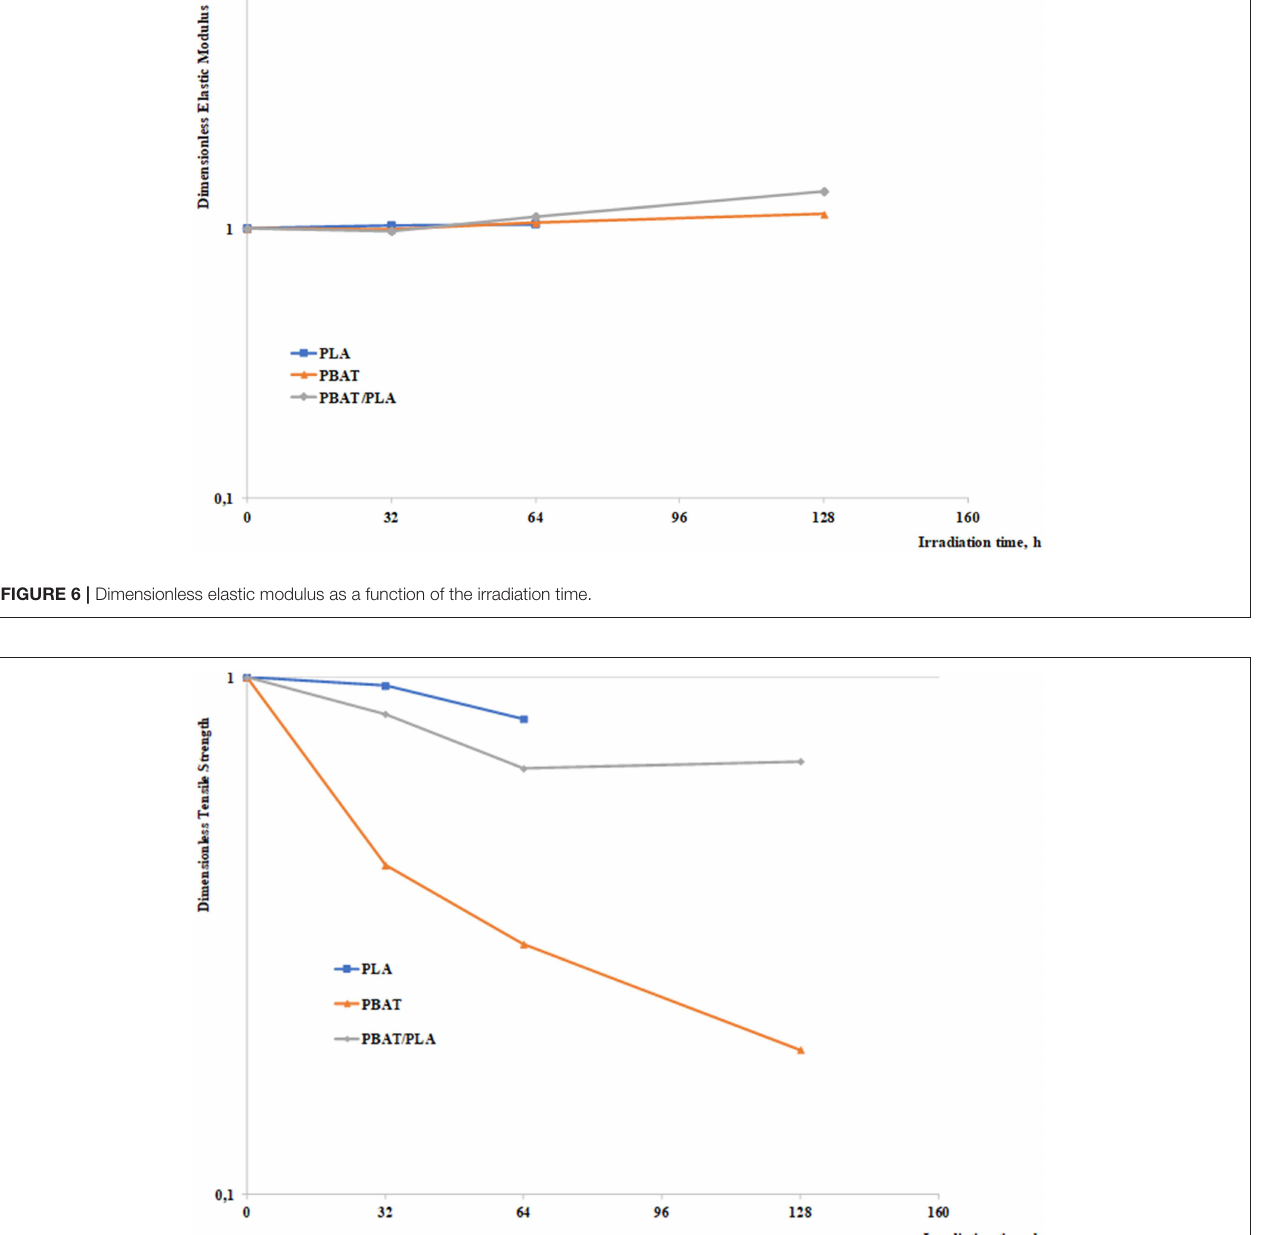
Frontiers in Materials |